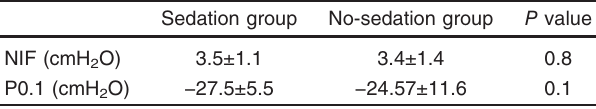
Table 2 Effect of sedation on respiratory muscle determinants Sedation